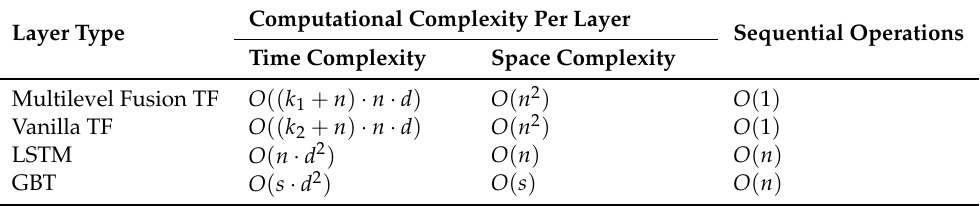
Table 5. Per-layer computational complexity and minimum number of sequential operations for different layer types. n = T obs is the sequence length; d is the node dimension; k 1 and k 2 are kernel sizes ( k 1 > k 2 ); s is the random permutations ( s (cid:29) n ).